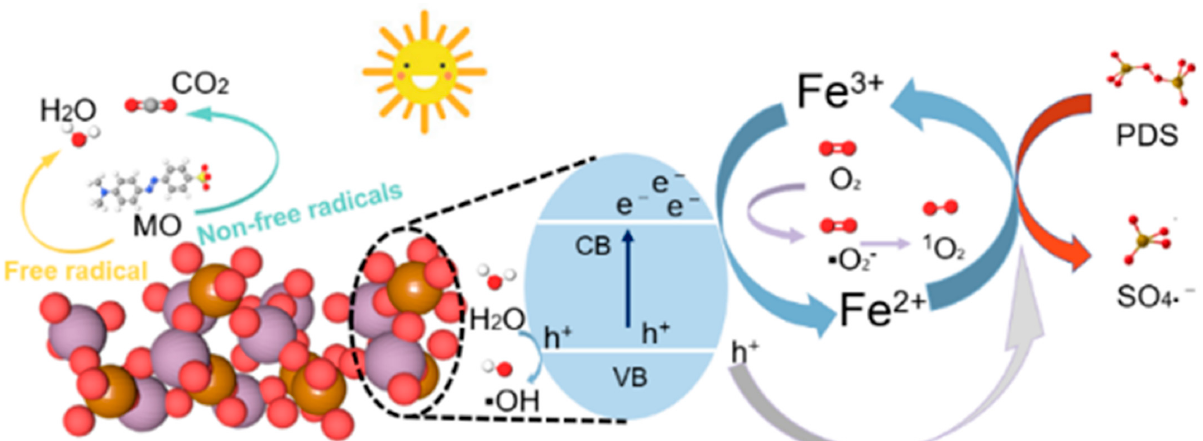
Figure 7. Possible mechanisms for synergistic degradation of MO by the FMO photoFenton sys-